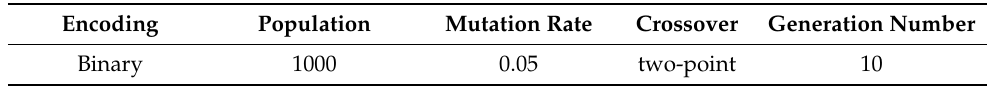
Table 1. Configuration of NSGAII.